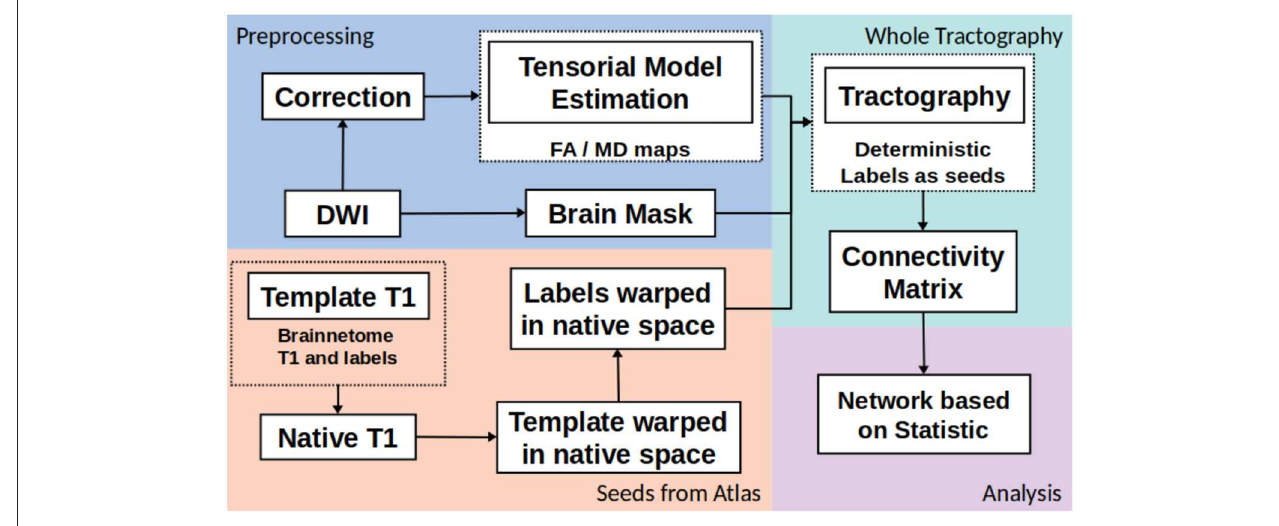
FIGURE 1 | General pipeline of DTI processing and matrix